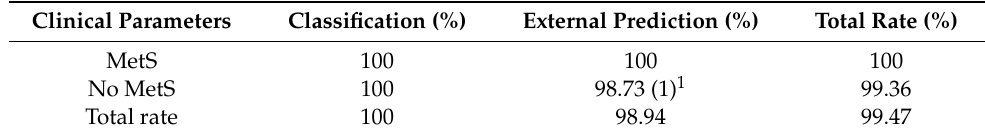
Table 2. Results of LDA classification performance on clinical parameters.